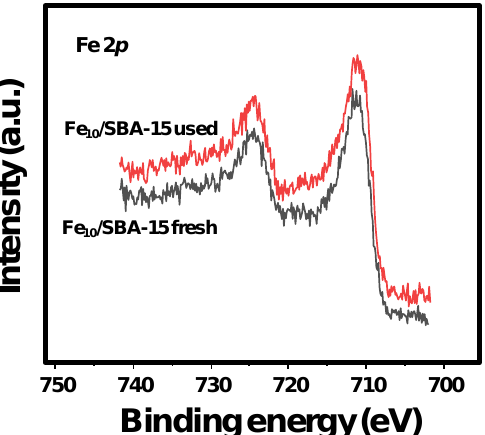
Figure 5. Fe 2 p core level spectra for Fe 10 /SBA-15 fresh and used.